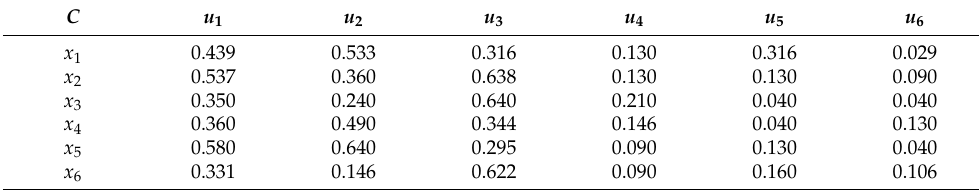
Table 9. Overall decision matrix.